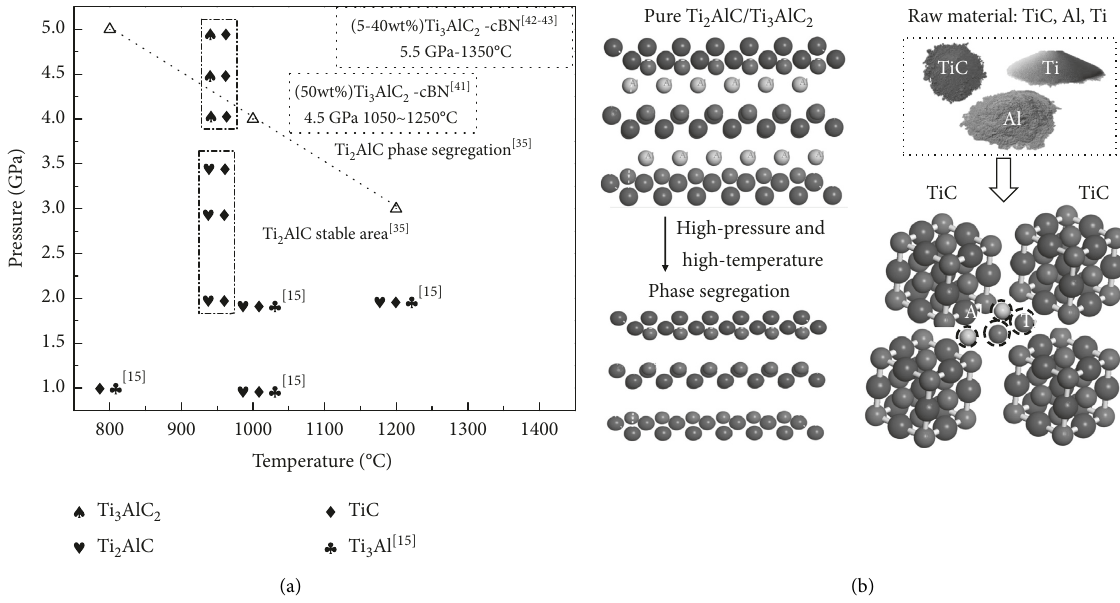
Figure 4: Stable area of Ti 2 AlC or Ti 3 AlC 2 composites (a); possible mechanism of the enhancement of Ti 2 AlC or Ti 3 AlC 2 stability